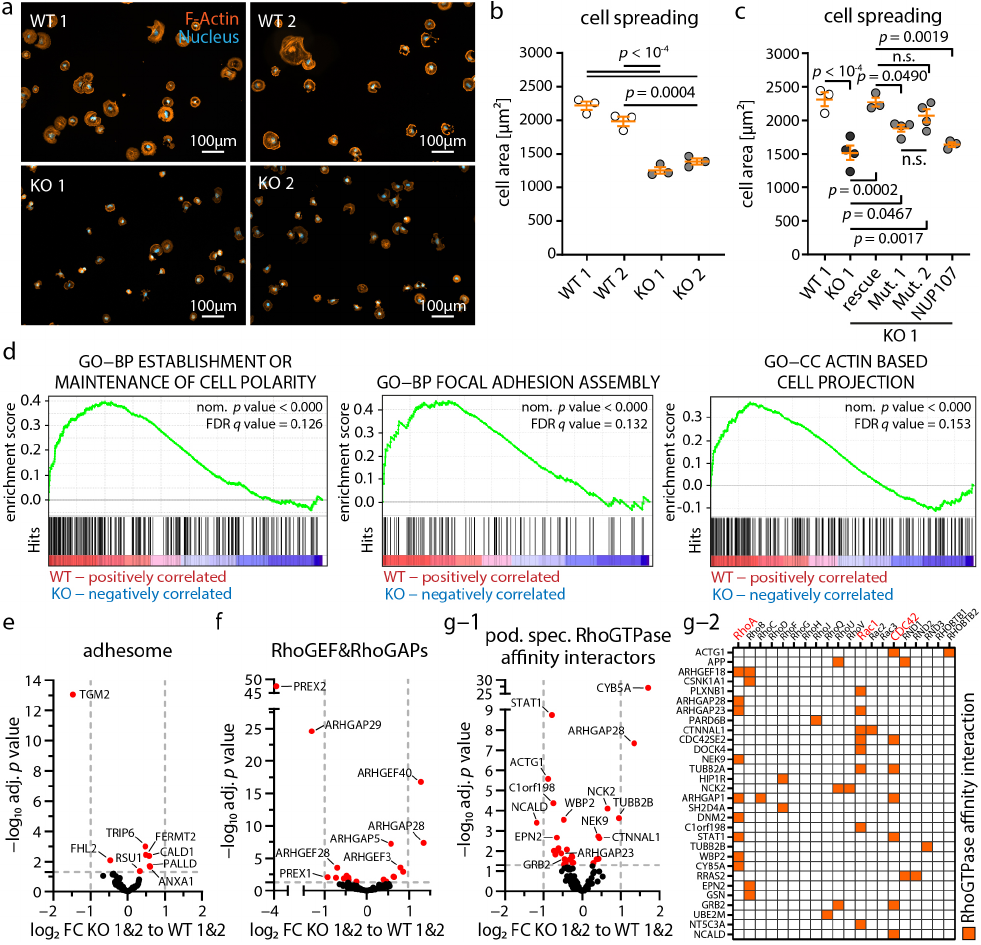
Figure 6. Loss of NUP133 disturbs dynamic cytoskeleton regulation in podocytes. ( a – c ) Cell spreading analysis of NUP133 WT, KO, and mutant cell lines showed reduced spreading capacity of KO and mutant podocytes (F-actin was stained by phalloidin and nuclei by Hoechst 33342). Mean cell areas, from at least three independent experiments per genotype and clone, are shown (scatterplots indicate mean values of independent experiments, at least 100 cells per replicate were analyzed; n. s.—non-significant). ( d ) Representative GSEA plots of enriched gene ontology (GO) gene sets, cor- relating with cell adhesion, protrusion, and polarization. ( e – g-2 ) Volcano plots of differential ex- pression analysis of NUP133 KO-1&2 versus WT-1&2 clones. Red dots indicate significantly regu-